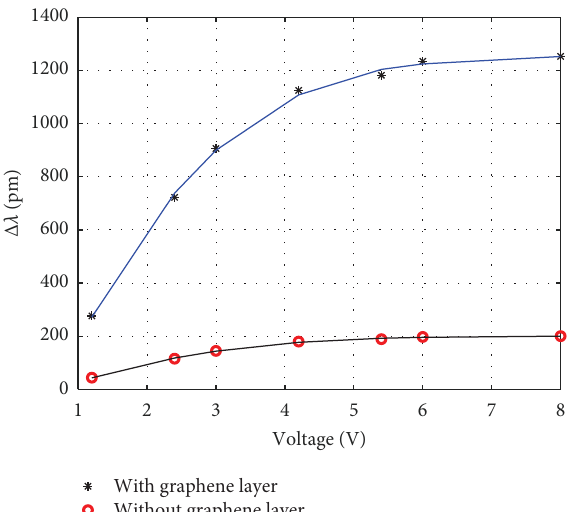
Figure 10: Tuning efciency evaluation. Te resonant wavelength shifts as a function of the applied DC voltage with nonlinear